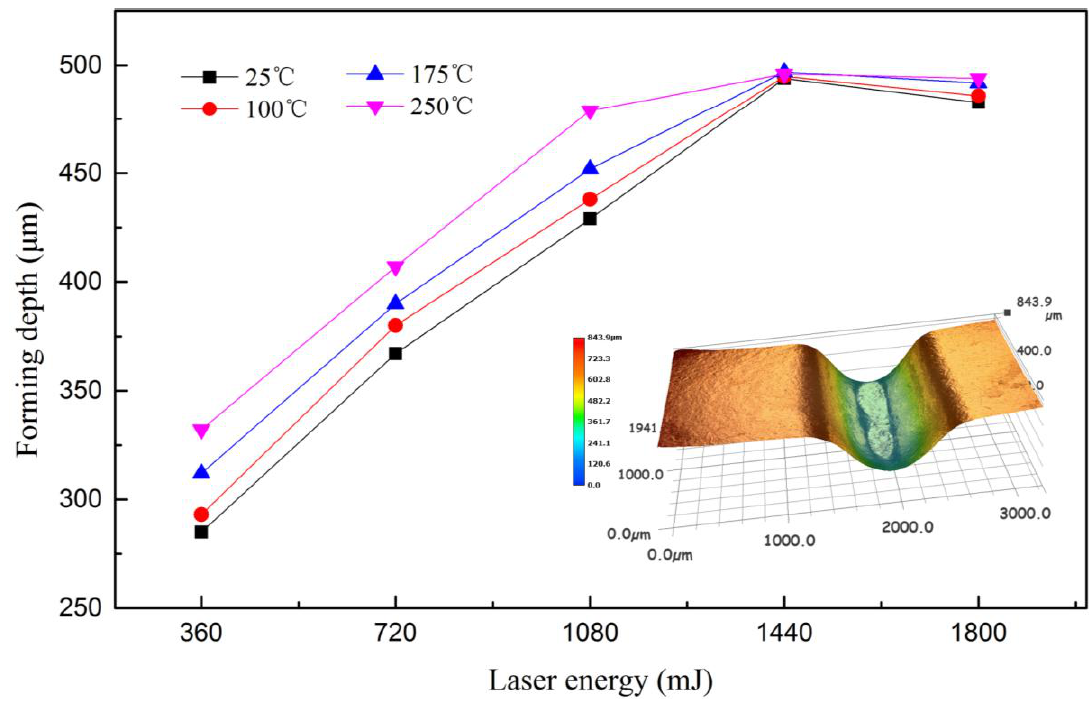
Figure 4. Influence of laser energy and temperature on forming depth.